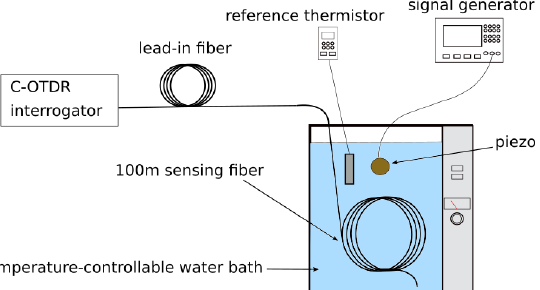
Figure 5. Experimental setup with scatterer dot sensing fiber in temperature-controllable water bath. Vibration is employed via a submerged piezo operated via a signal generator. The temperature evolution was measured with an Almemo thermistor for